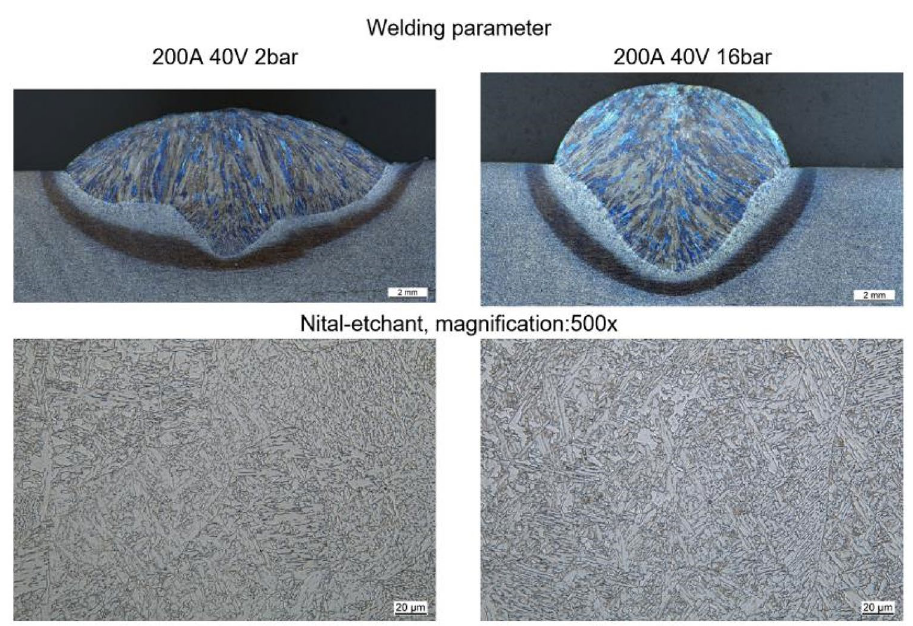
Figure 9. Shape and microstructure of the weld for different ambient